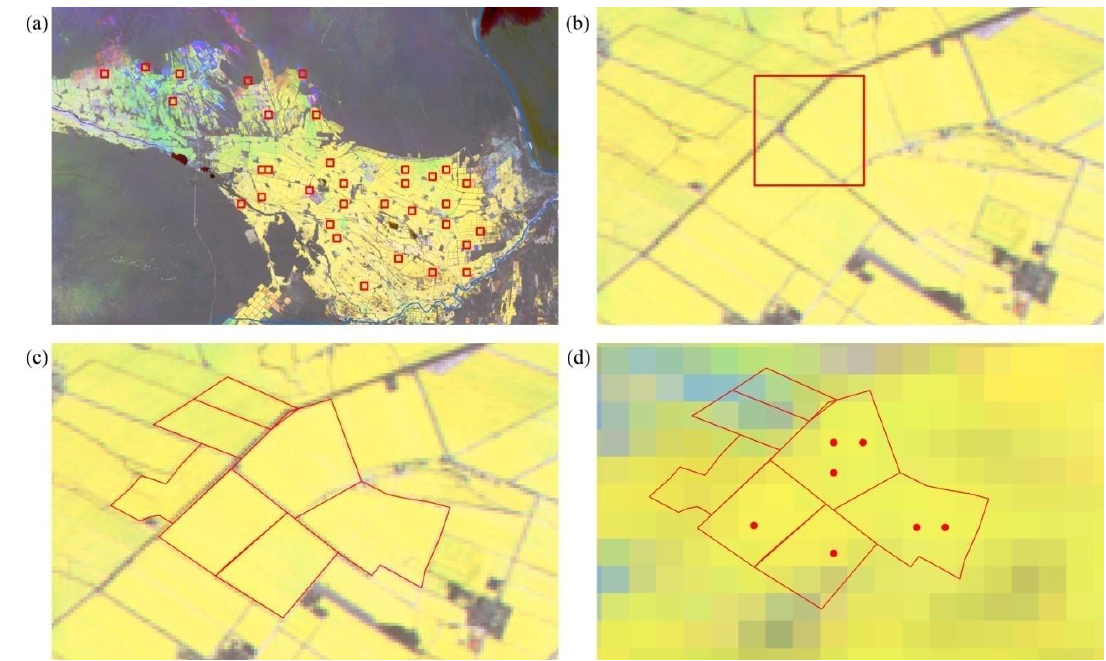
Figure 2. Distributions of ground reference data: ( a ) Bole; and ( b ) Manas.